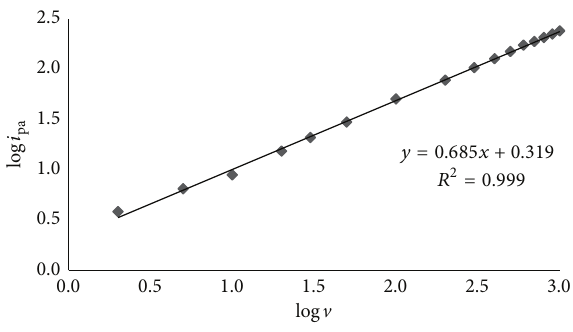
Figure 4: Plot of log 𝑖